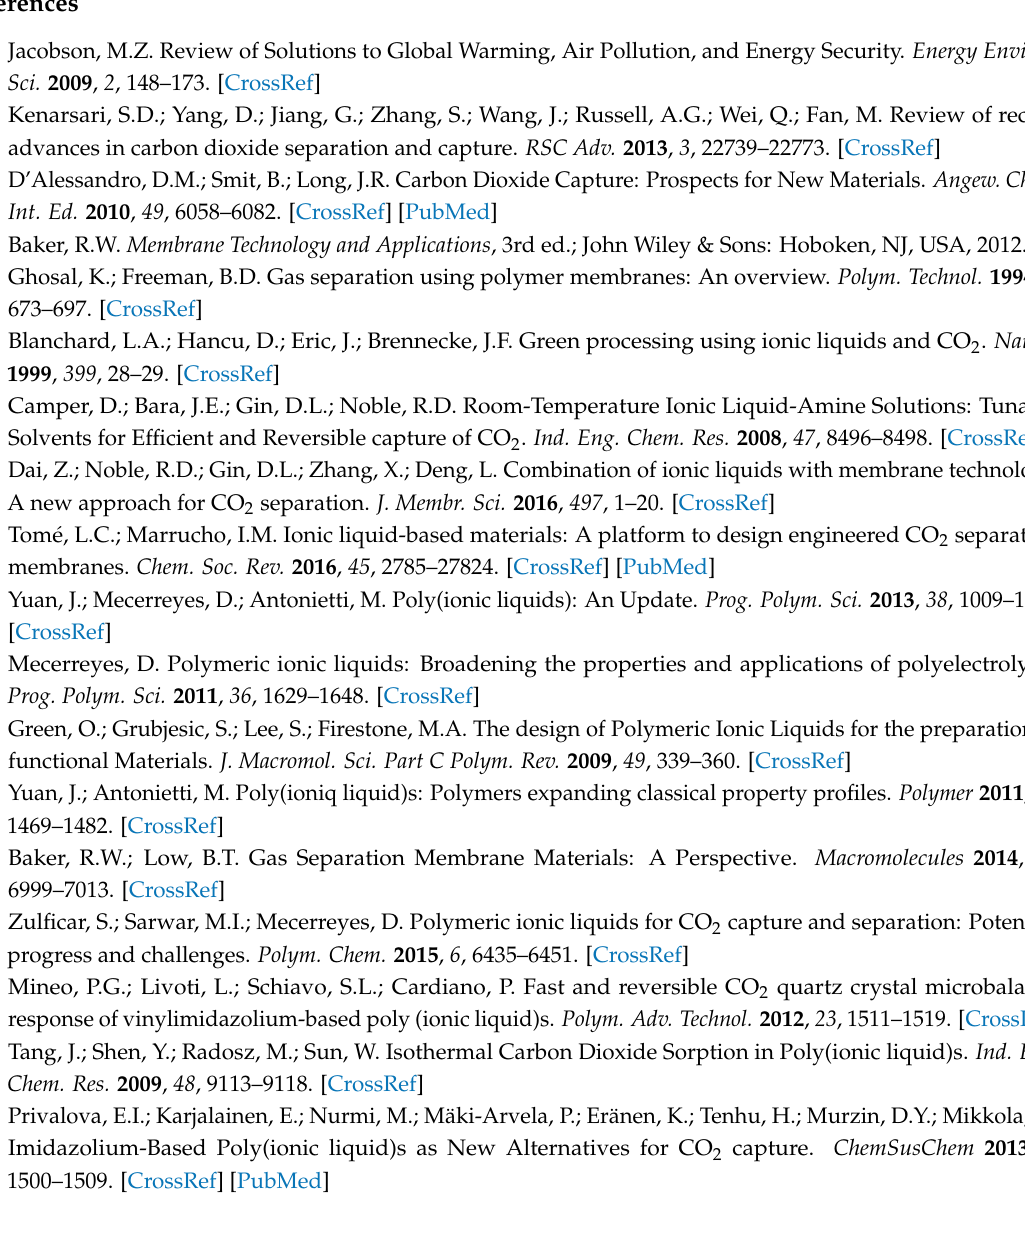
Figure S1: 19 FNMR spectrum for PIL containing TFSI − as anion, Figure S2: 19 FNMR spectrum for PIL containing BF 4 − as